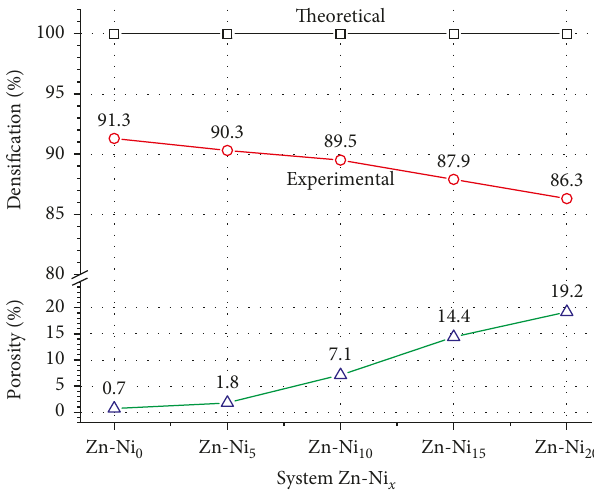
Figure 2: Densification behavior and porosity from powder alloys of Zn-Ni x